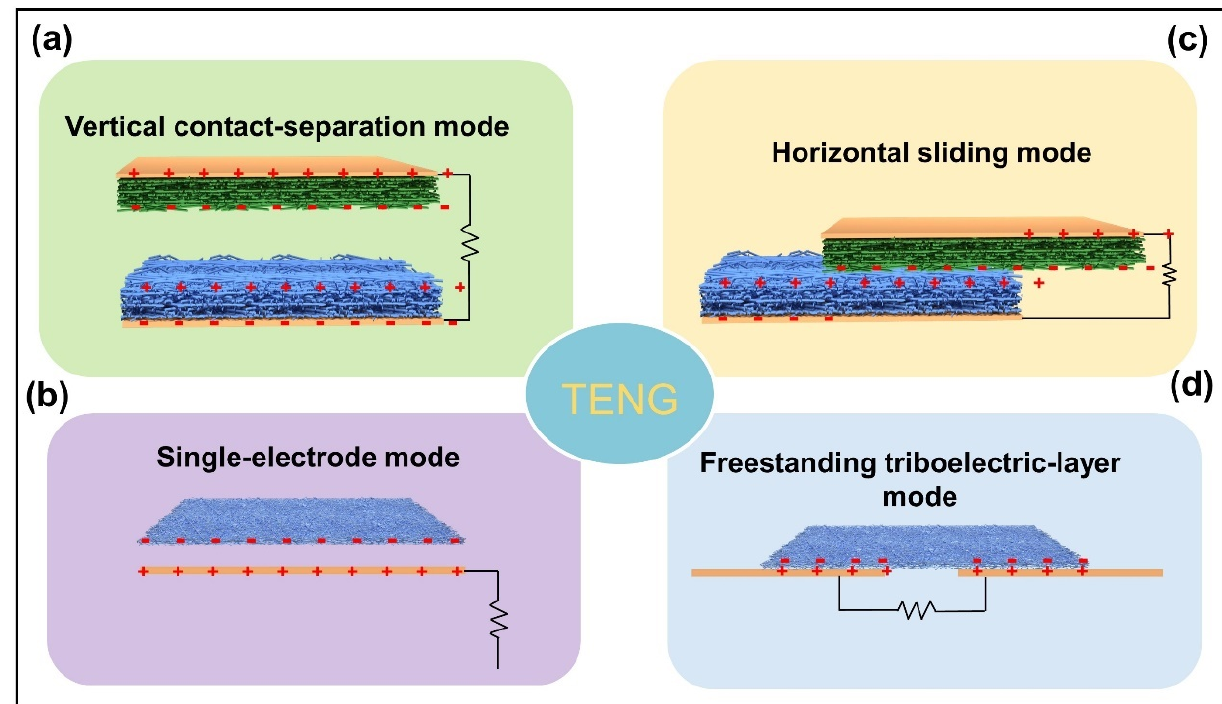
Figure 3. The basic structure mode of TENGs. ( a ) Vertical contact ‐ separation model. ( b ) Single ‐ electrode mode. ( c ) Horizontal sliding mode. ( d ) Freestanding triboelectric ‐ layer mode.